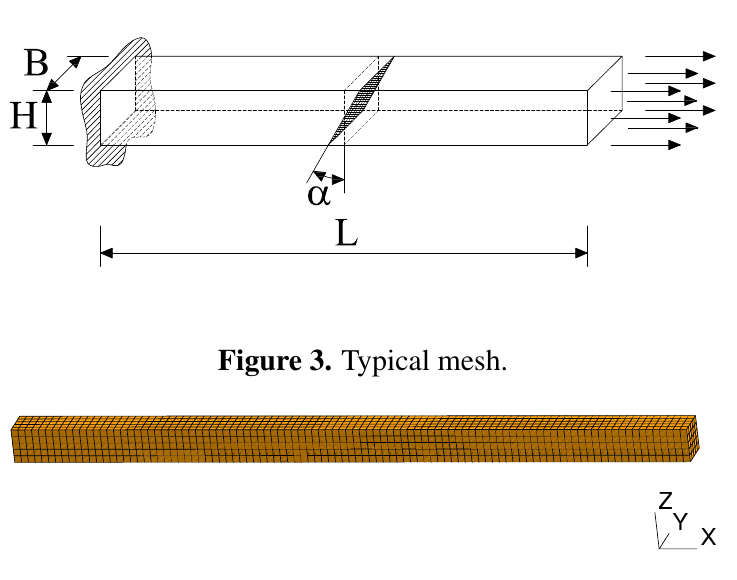
Figure 2. Geometry of the uniaxial test.